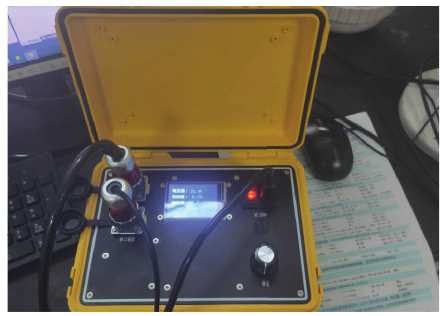
Figure 4: Lower computer control